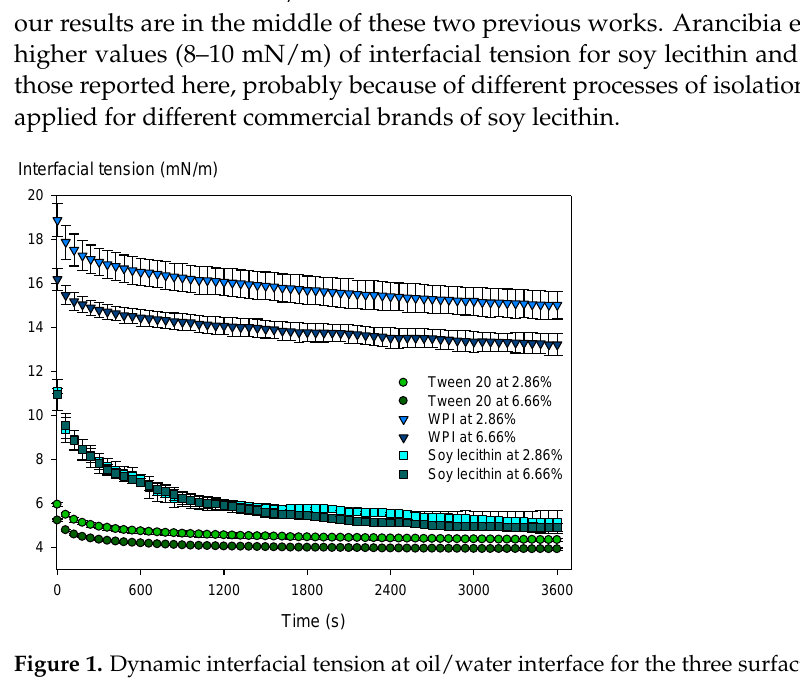
Figure 1. Dynamic interfacial tension at oil/water interface for the three surfactants studied. Error bars represent one standard deviation. Table 1. Fitting parameters of the dynamic interfacial tension curves.